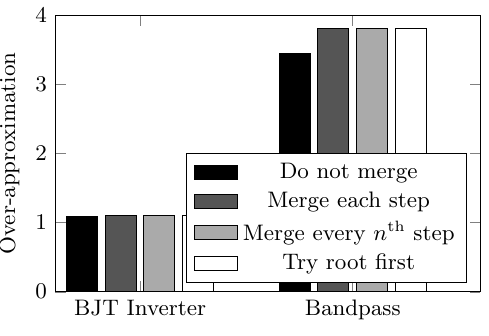
Figure 17: Over-approximation m OA for different merge strategies Additionally, the over-approximation can be reduced by em- ploying more splits. For higher dimensional systems split- ting all parameters leads to excessive runtimes as the num- ber of parts to calculate increases exponentially. To avoid this drawback different strategies for splitting and merging were presented and compared. The split strategies select one parameter to split by different criteria. The best split strategy in terms of runtime is “select by deviation” which selects the parameter with the largest deviation for split- ting. This reduces the runtime to 3 % of the time needed to split all parameters for the bandpass example. For tran- sient simulations different merge strategies were